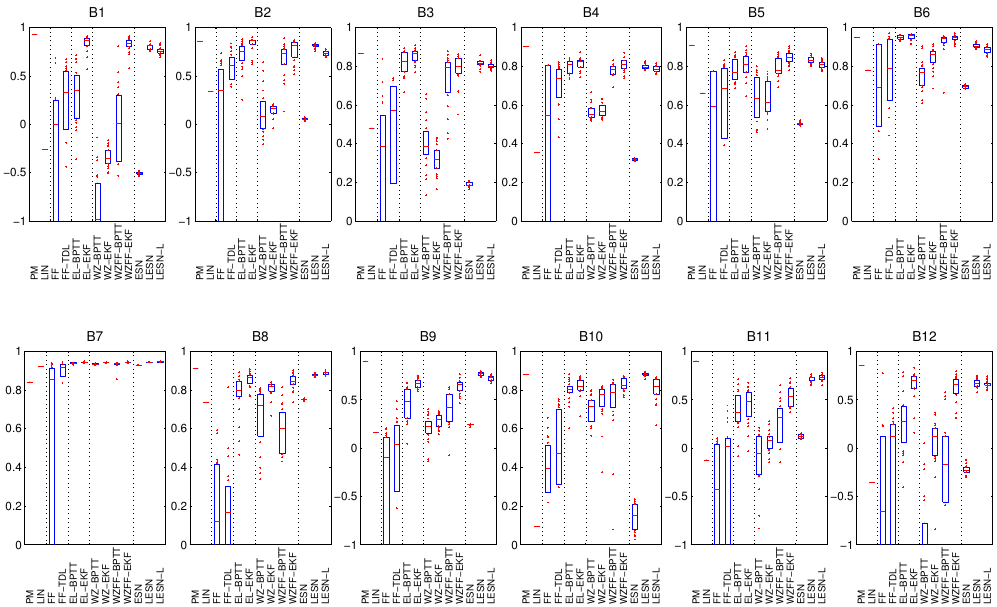
Fig. 6. Test performance in terms of CE log . The box plot expresses statistics of over 20 models runs. The central mark is the median, the edges of the box are the first and third quartiles, and points outside that range are plotted individually as dots. Note that not all subfigures have the same